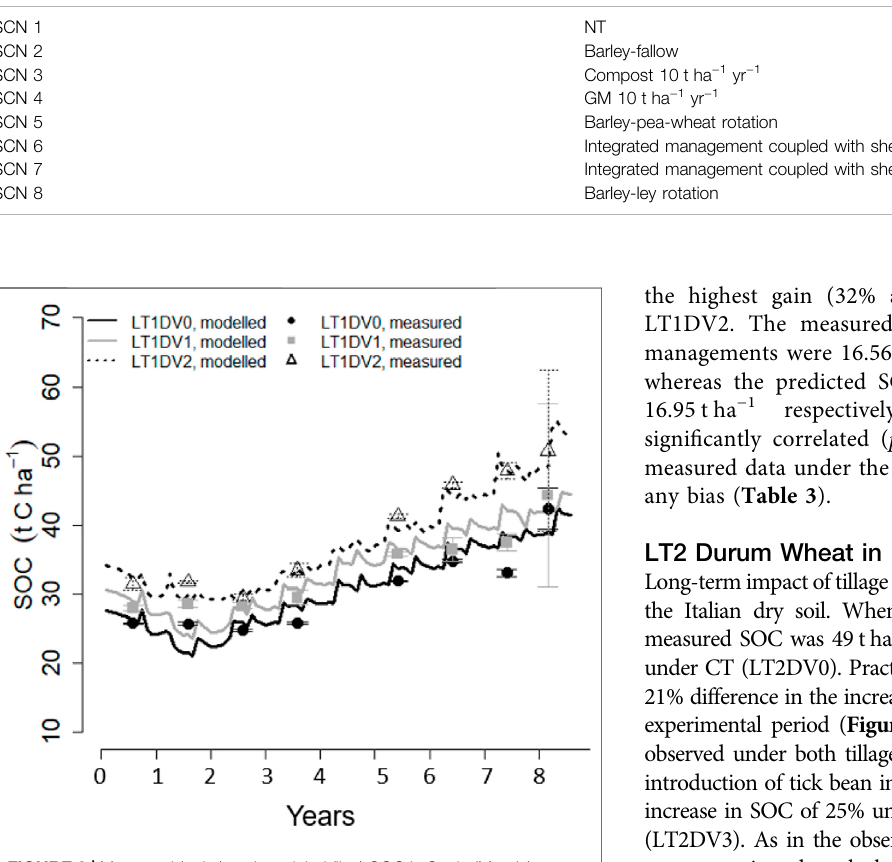
FIGURE 3 | Measured (point) and modeled (line) SOC in Spain (Murcia) Horticulture site, LT1, under conventional (LT1DV0), organic (LT1DV1), and diversi fi ed management (LT1DV2) for the period 2010 – 2018 at 0 – 30 cm depth. The error bar indicates standard deviation of the measured SOC.